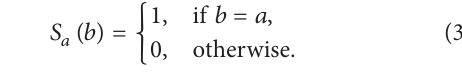
𝑓 (𝑋 𝑟 ) of person 𝑦 𝑖 𝑟 . 𝑘